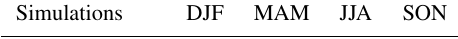
Table 2. Seasonal root-mean-square error (RMSE, in hectopascals) on mean SLP south of 20 ◦ S with respect to ERA-Interim for the different ARPEGE simulations over the 1981–2010 period. Each error is significant at p = 0 . 05.